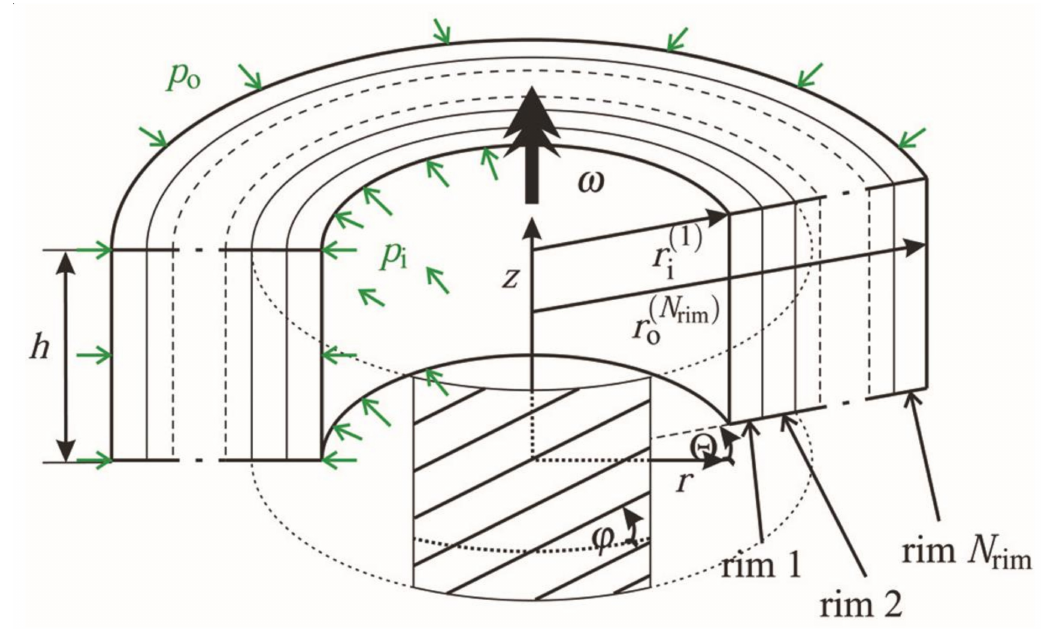
Figure 26. Rotor set up for flywheel, adapted from